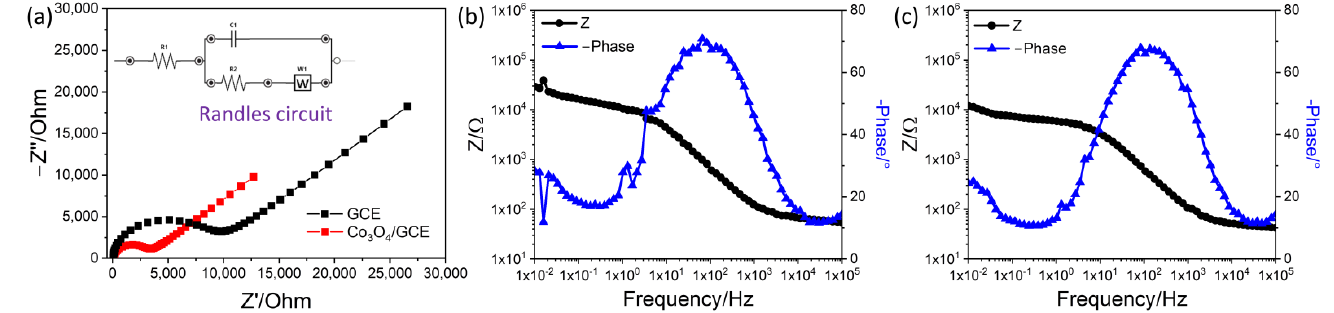
Figure 3. EIS spectra of bare GCE and cobalt oxide/GCE electrodes recorded in the redox probe solution of [Fe(CN) 6 ] 3−/4− with KCl (0.1 M) “as supporting electrolyte”. ( a ) Nyquist plots of bare GCE (black line) and cobalt oxide/GCE (red line) electrodes and their respective Bode plots ( b and c ). Inset a shows the Randle circuit.